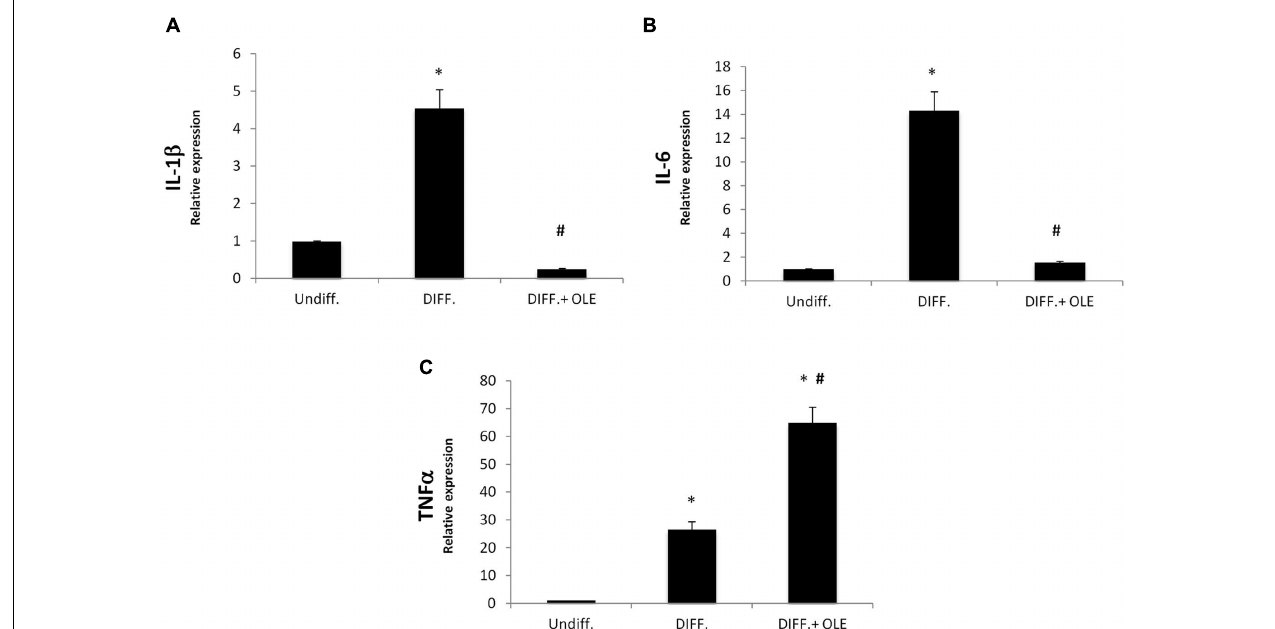
FIGURE 4 | Analysis of gene expression by Real time PCR of cytokines IL-1 β (A), IL-6 (B), and TNF α (C). All values are expressed as mean ± SEM of four experiments ( n = 4) in duplicate. ( ∗ P < 0.05 versus undifferentiated; # P < 0.05 versus differentiated).